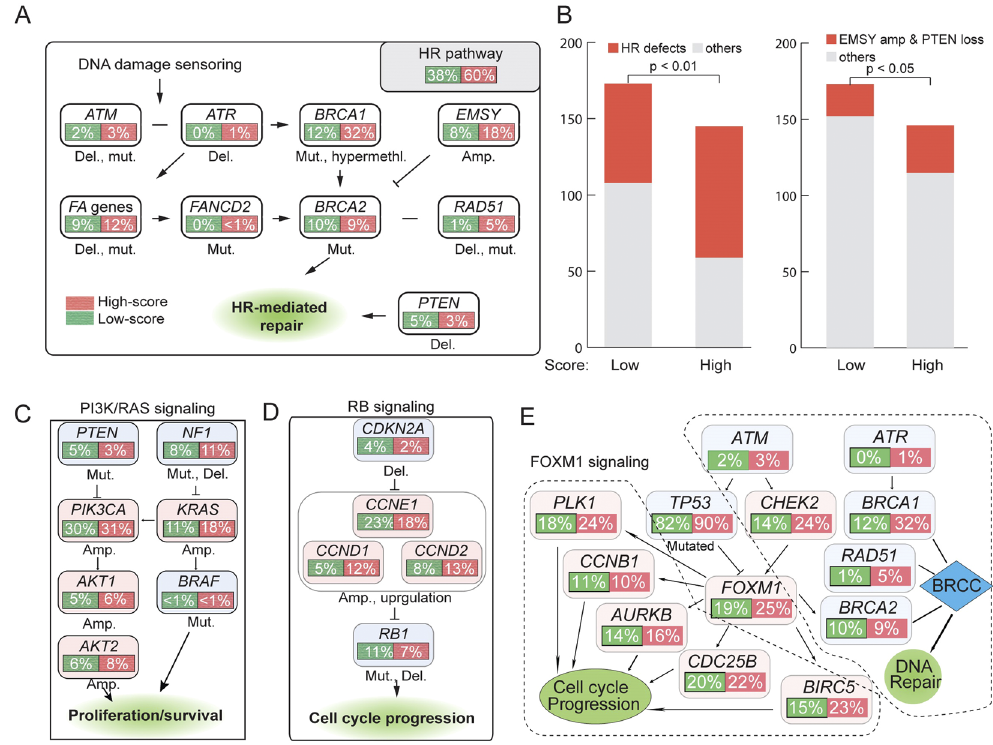
Figure 3. The 10-miRNA-score predicts defects in the HR pathway in ovarian cancer. ( A ) The genomic alterations in HR pathway related genes between the high 10-miRNA-score (green) and low 10-miRNA-score (red) groups in ovarian cancer. ( B ) Frequency of HR defects. The left panel shows the frequency of HR genes in the high 10-miRNA-score group compared with that in the low 10-miRNA-score group. The right panel shows the number of tumours with amplification of EMSY or copy number loss of PTEN in the high 10-miRNA-score and low 10-miRNA-score groups. ( C , D and E ) Alterations of the PI3K/RAS ( C ), RB ( D ) and FOXM1 ( E ) signalling pathways that are commonly altered in ovarian cancer. Alterations are defined by somatic mutations, amplifications and up- or downregulated gene expressions. The background colour of each node represents activation (light blue) or inactivation (light red). The percentages of alteration are in green frames for the low 10-miRNA-score group or in red frames for the high 10-miRNA-score